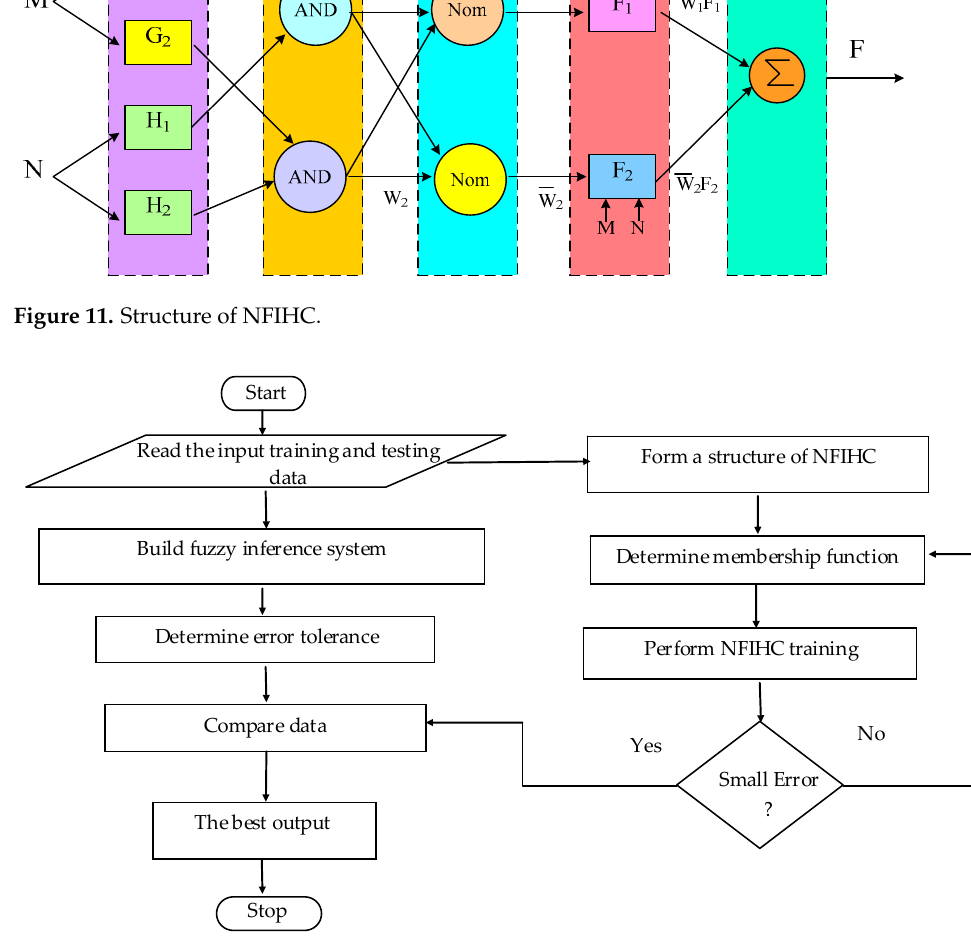
Figure 12. Flow of the proposed method.